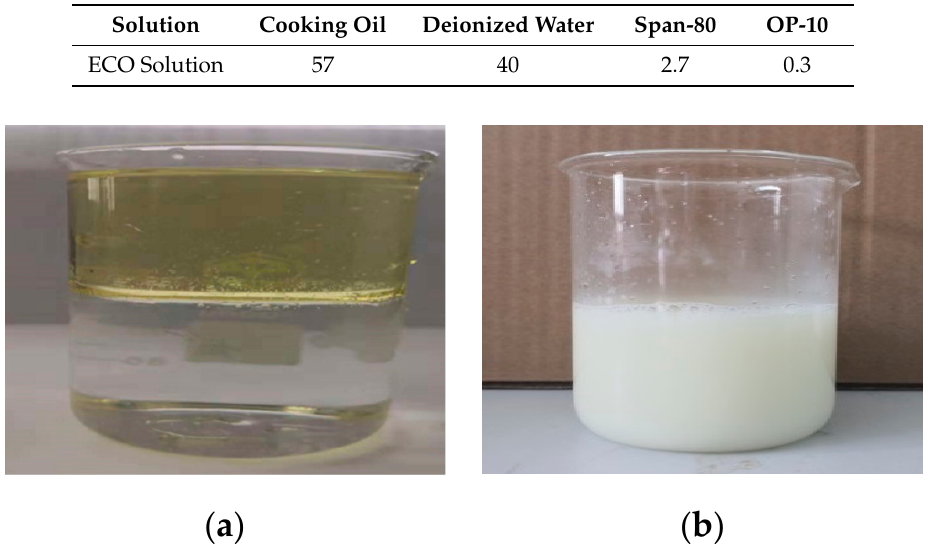
Figure 2. Water and oil solution ( a ) before and ( b ) after emulsification.